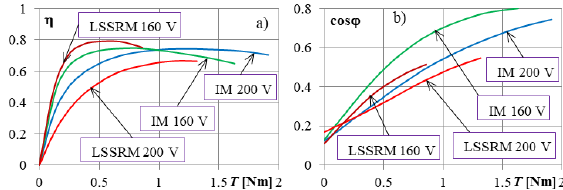
Fig. 6. Characteristics: (a) n ( T ) of IM and (b) T ( β ) of LSSRM from calculations (C) and measurements (M).